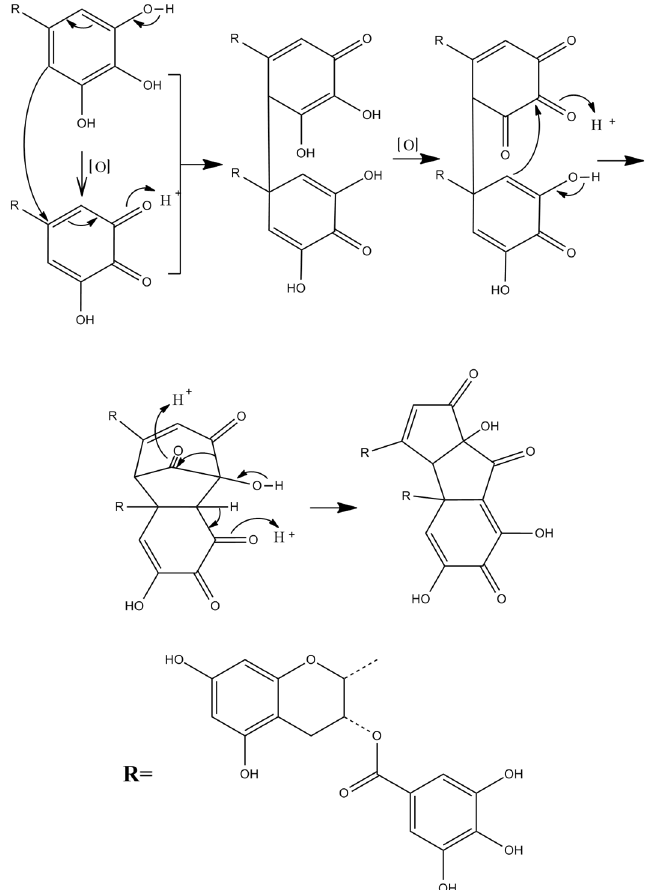
Figure 11. The possible mechanism for the formation of theacitrin C.